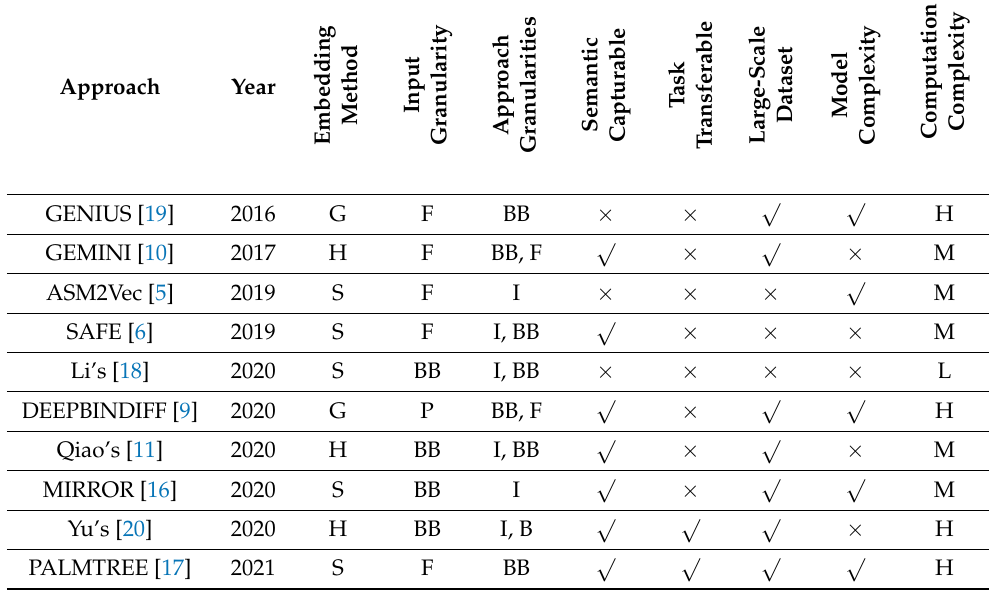
Table 1. Comparison among binary embedding methods. For Boolean columns: × —unsupported. Embedding method can be sequence based (S), graph based (G), or a hybrid structure (H). Input granularity and approach granularities can be instruction (I), basic block (BB), function (F), or program (P). Computation complexity can be high (H), moderate (M), or low (L).